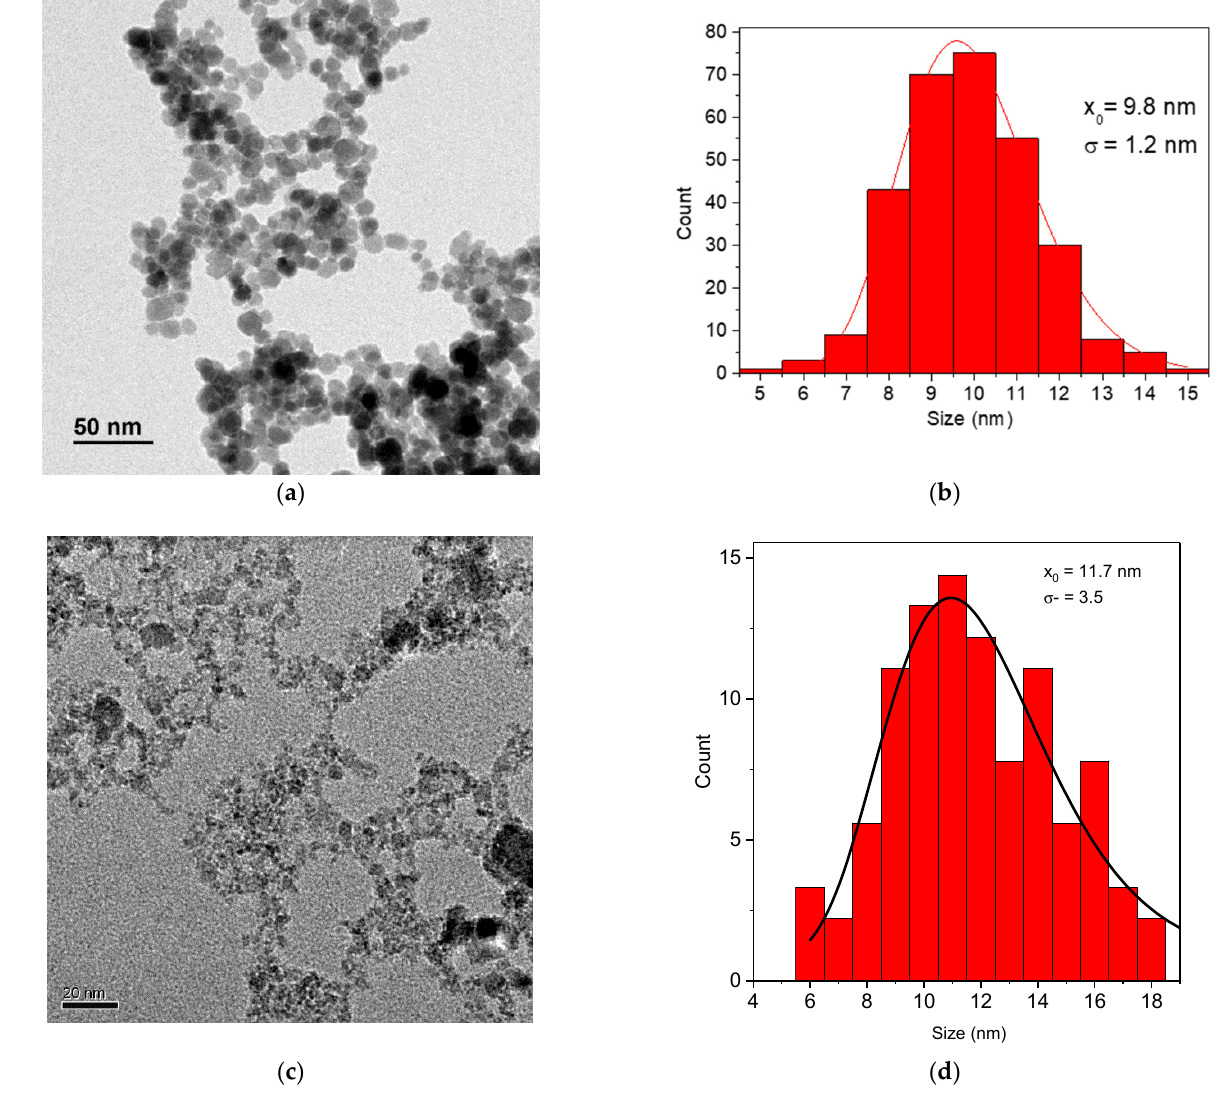
Figure 1. TEM image ( a ) and size distribution ( b ) of γ -Fe 2 O 3 NPs and TEM image ( c ) and size distribution ( d ) of MnFe 2 O 4 NPs. (Figures 1c and 1d reprinted with permission from ref. [15]. Copyright 2016 Elsevier).